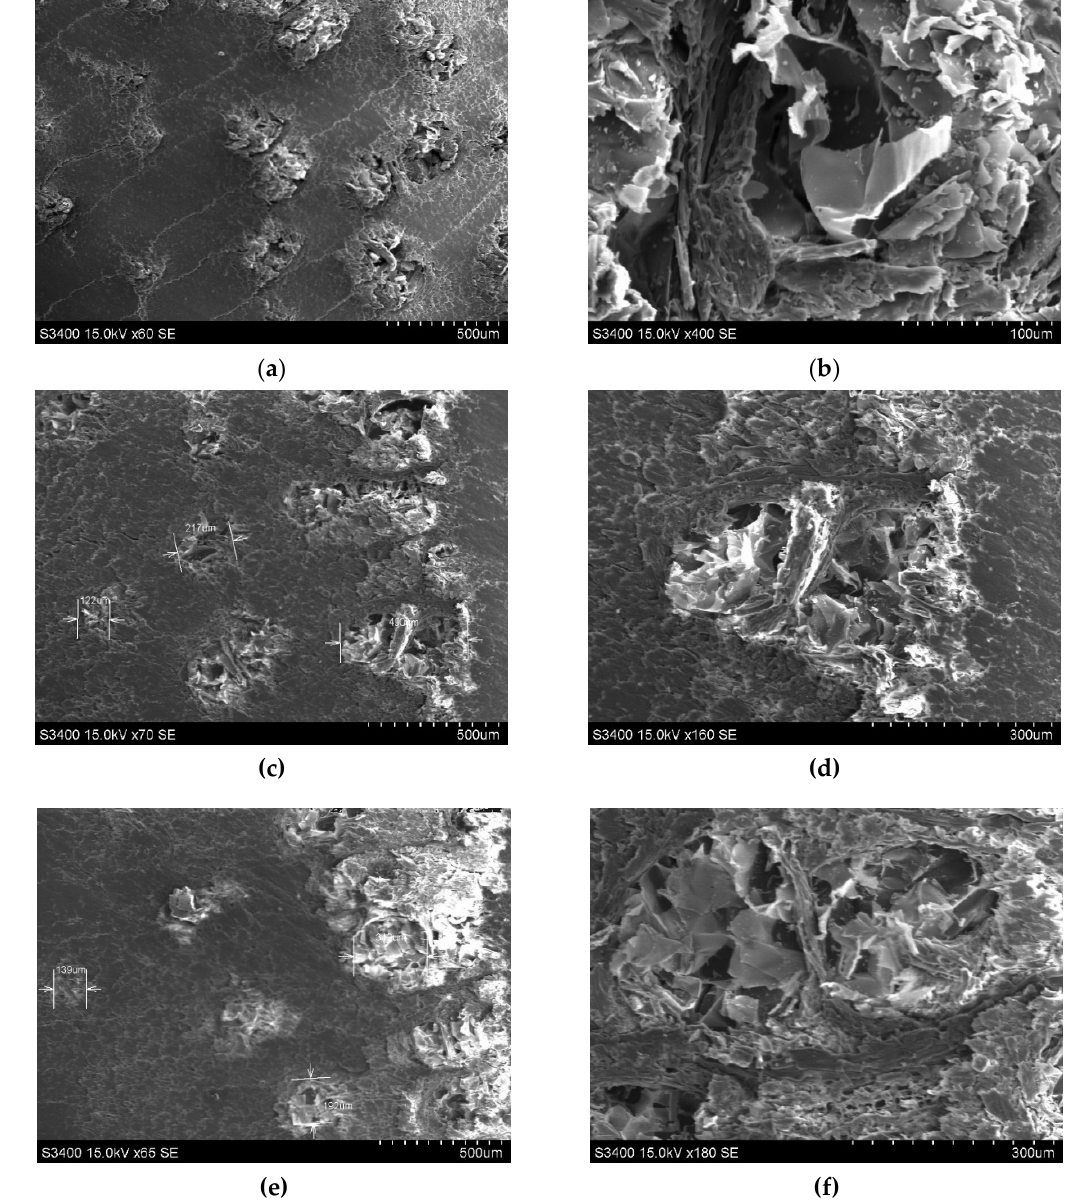
Figure 16. SEM view on cross-section of wood: ( a ) control sample magnification × 60 SE; ( b ) control sample magnification × 400 SE; ( c ) sample T1 (first treatment) magnification × 70 SE; ( d ) sample T1 (first treatment) magnification × 160 SE; ( e ) sample T2 (second treatment) magnification × 65 SE; ( f ) sample T2 (second treatment) magnification × 180 SE.